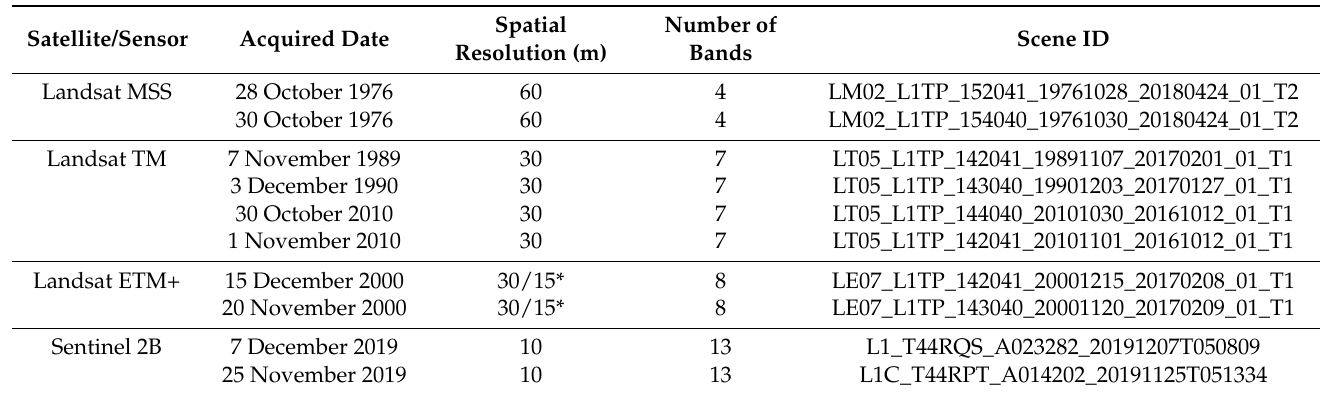
Table 2. Satellite data used in the